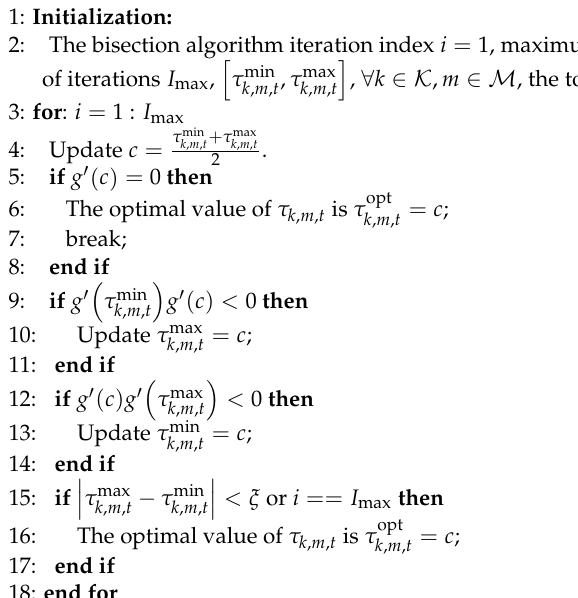
Algorithm 1 : A Bisection Algorithm for Solving P 6,